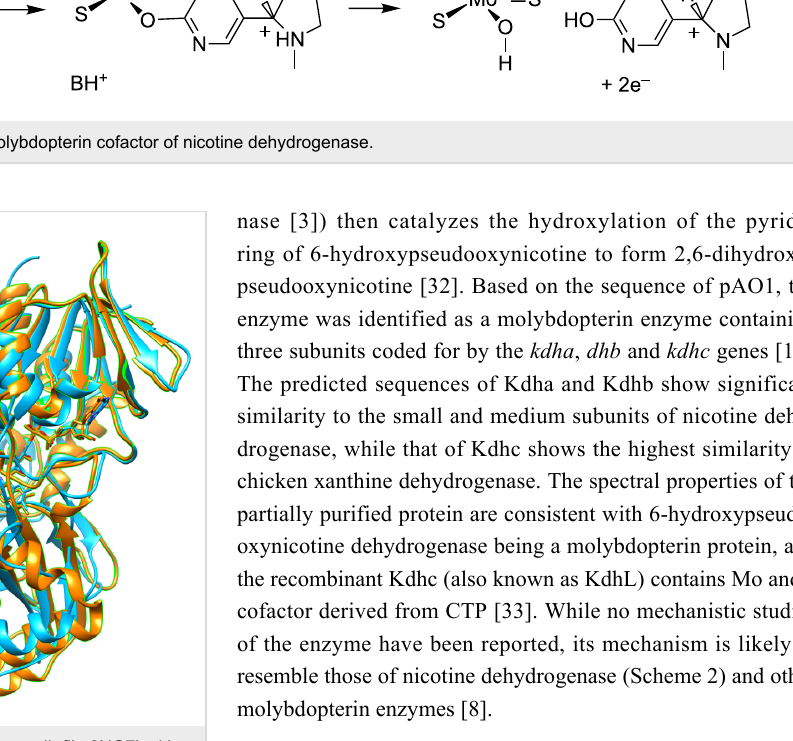
Figure 1: Overlay of the structure of LHNO (blue, pdb file 3NG7) with that of human MAO B (orange, pdb file 2FXU). The bound 6-hydroxyni- cotine is shown with green